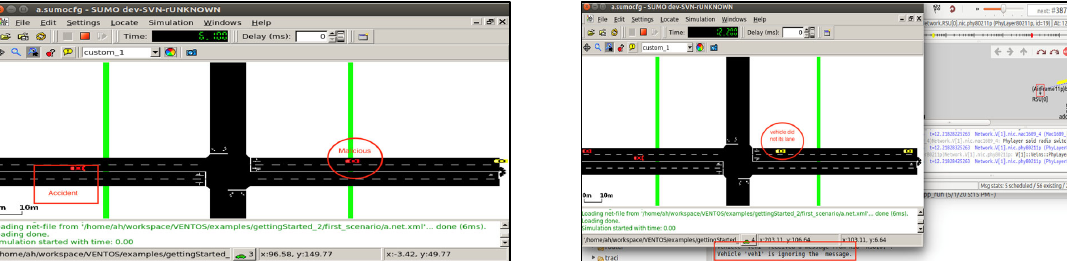
Fig. 12. Scenario 2: Vehicle did not Accepted the